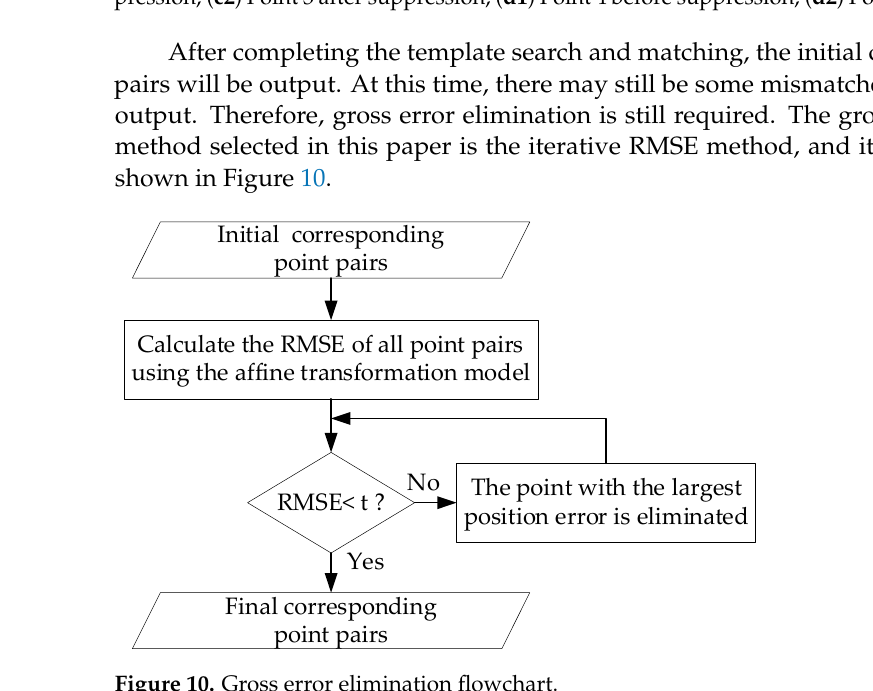
Figure 10. Gross error elimination flowchart.